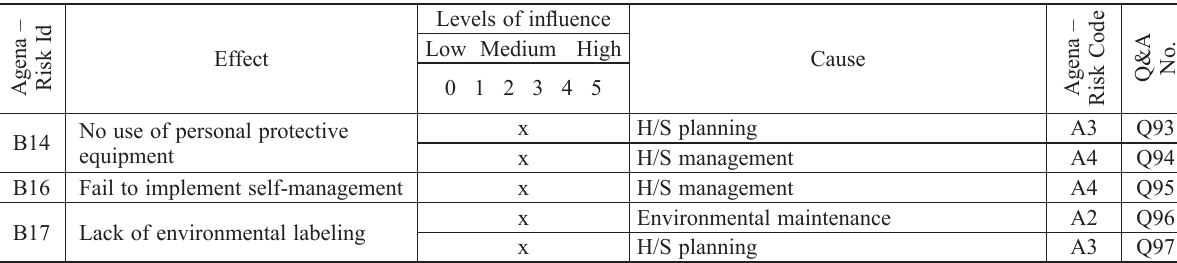
Table 3. Questionnaire example of relative weights of BN arcs